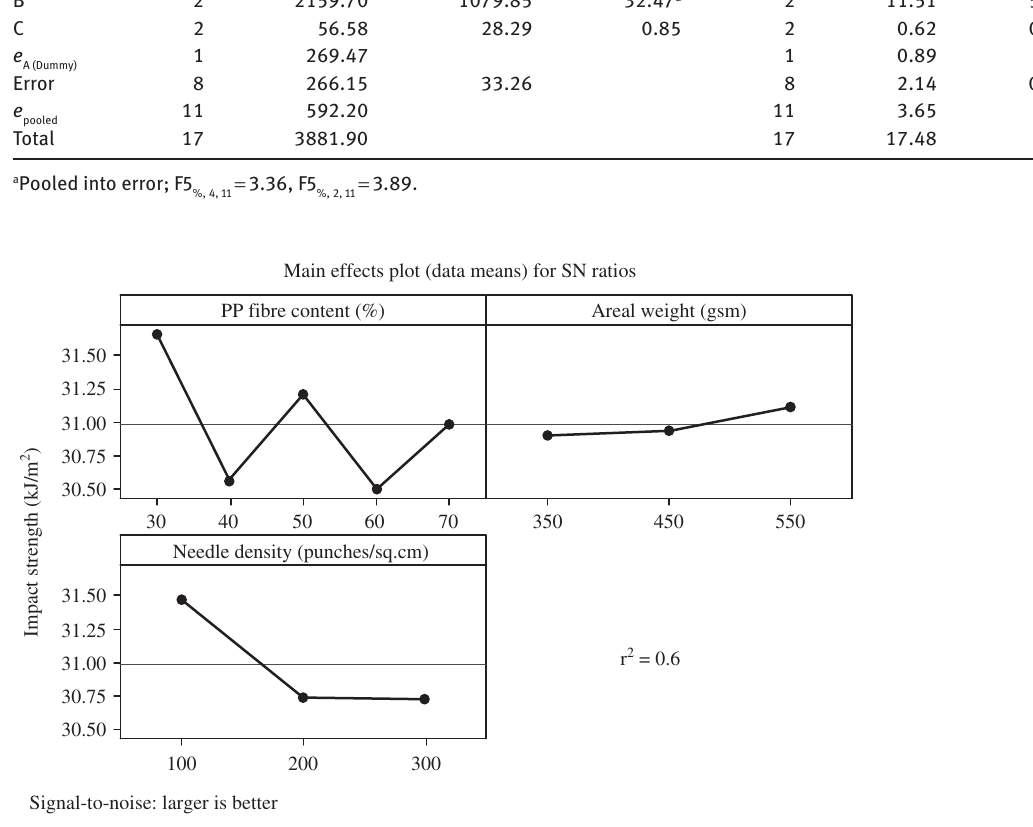
Figure 10: Impact properties of composites.